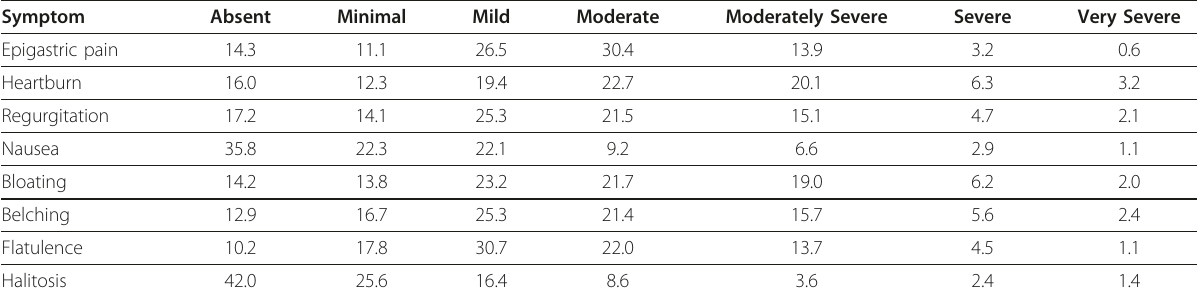
Table 1 Overview and grading of dyspeptic symptoms (%) in the study population Symptom Absent Minimal Mild Moderate